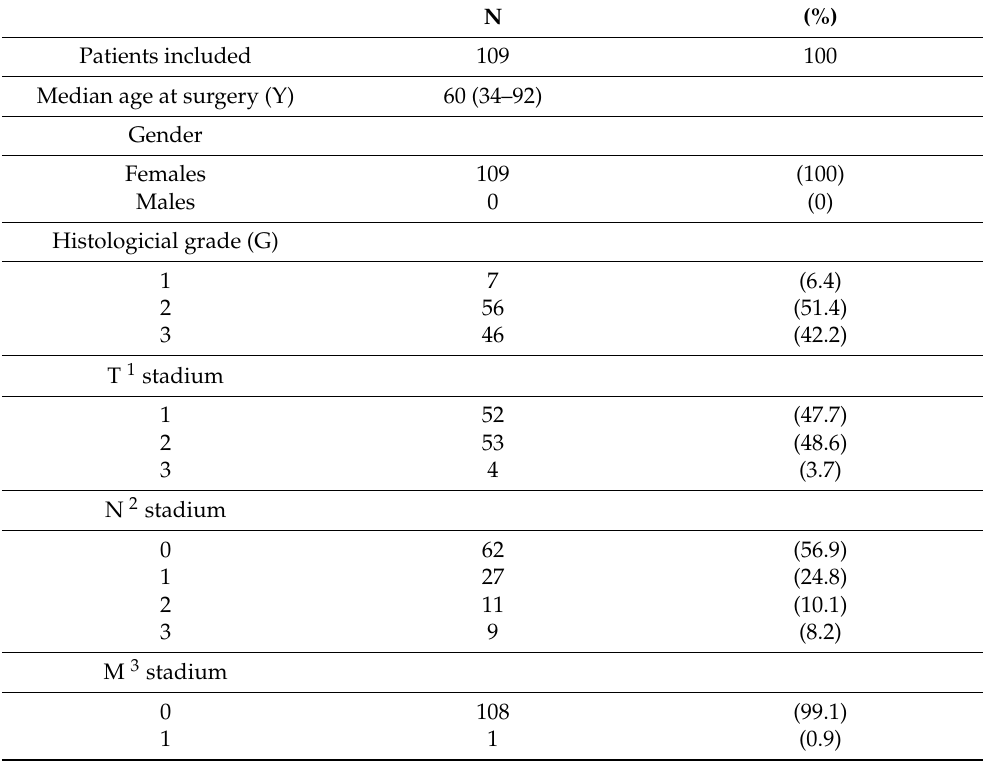
Table 1. Characteristics of the series of patients with breast cancer. N